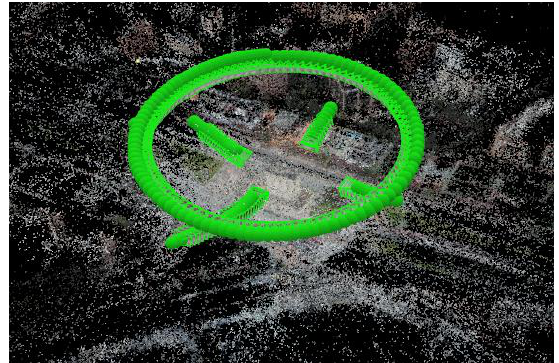
Figure 7: Distribution of the passage points of the Monument with processing with the frames generated by the drone tour. Source: Own elaboration.